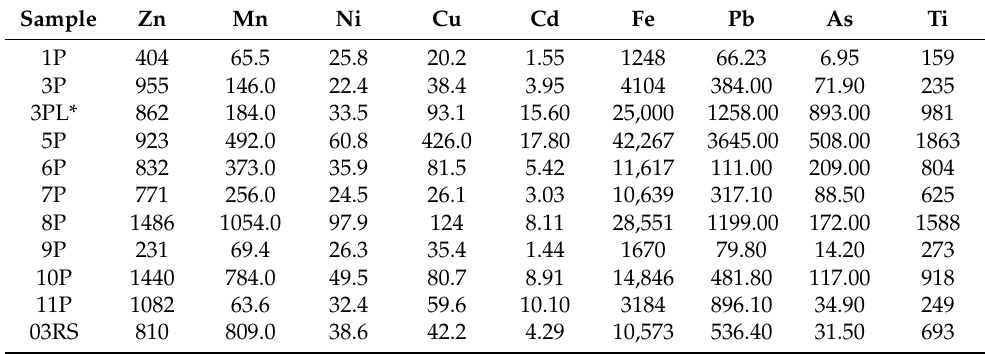
lichen (3PL*) on the heap in Ruda ´Sl ˛aska-Wirek